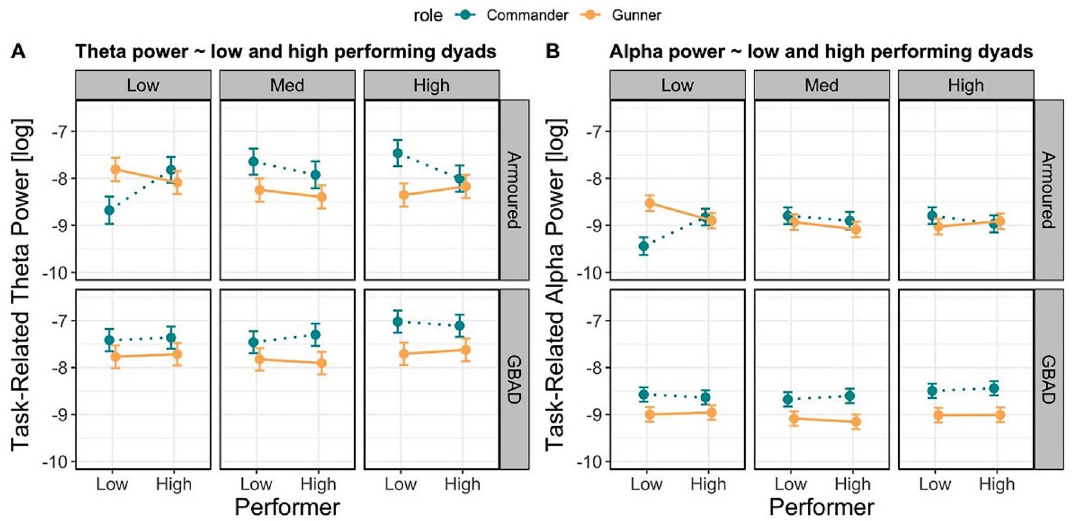
Figure 4. Modelled effects of task-related theta and alpha activity between low and high performing dyads. ( A ) Relationship between task-related theta power (y-axis; higher values indicate greater power), performer (x-axis; left = low performing dyad, right = high performing dyad), session (easy = left; medium = middle; high = right), and study (top row = Armoured; bottom row = GBAD). Estimates from commanders are represented by the dashed blue line, while estimates from gunners are represented by the solid orange line. Error bars represent the 83% confidence interval. ( B ) represents the same as ( A ) but for task-related alpha